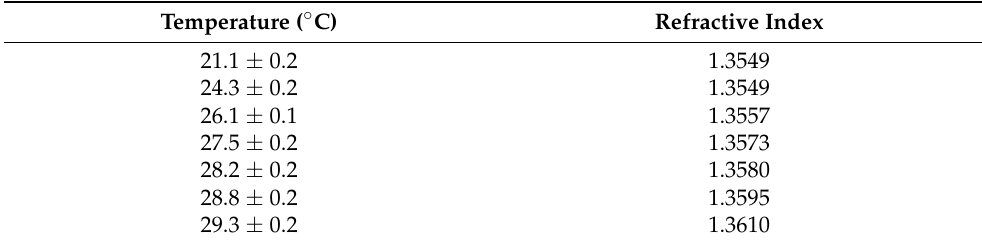
Figure 2. ( a ) Reflectance curve of pNIPAM solution considering the incidence angle of light and temperature, ( b ) magnified reflectance curve near the SPR angle. Table 1. Refractive index of pNIPAM solution (10 wt%).